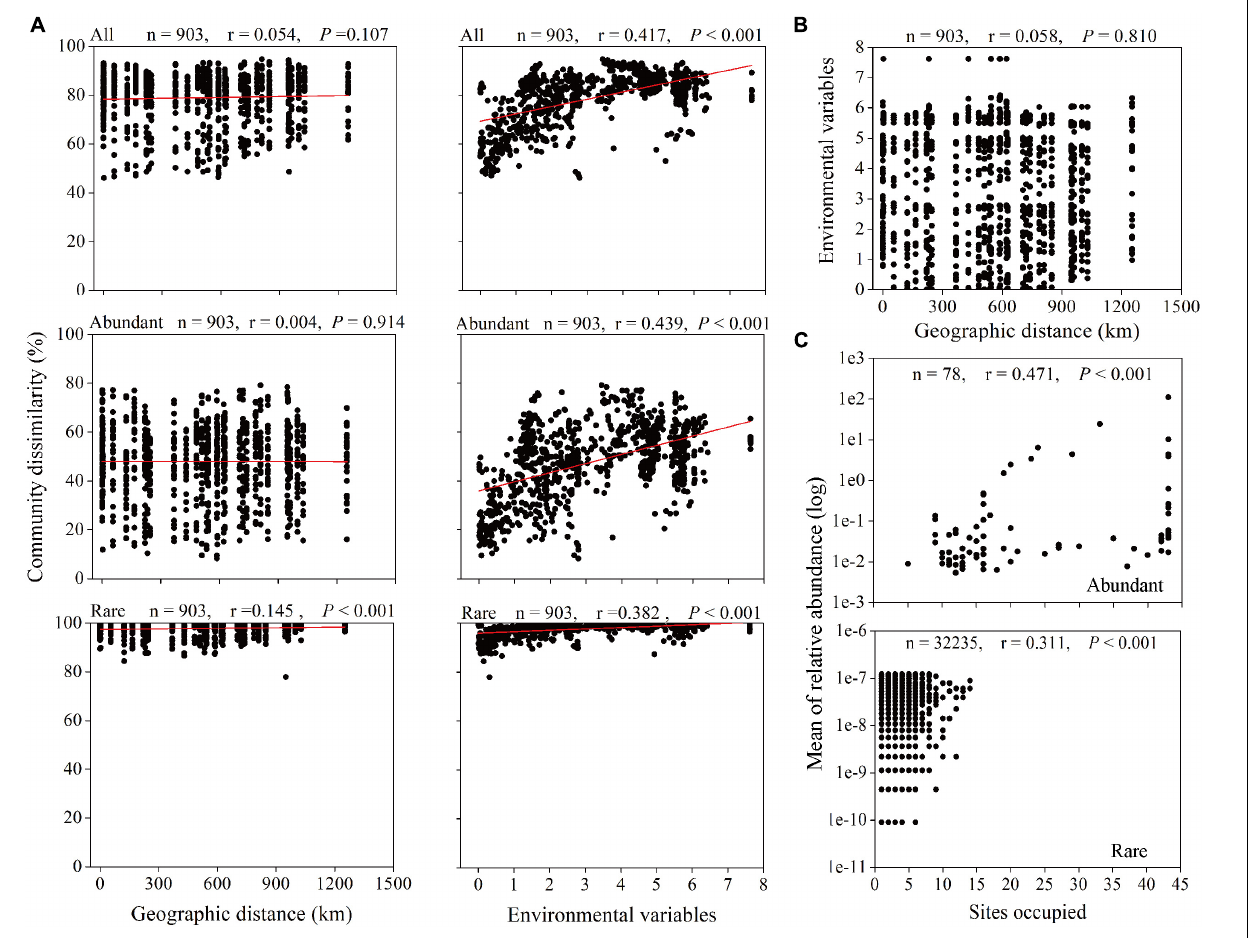
FIGURE 5 | Relationships between microbial community, geographic distance, and environmental factors. (A) Spearman’s rank correlations between the Bray–Curtis dissimilarity of microbial community and geographic distance and the Euclidean distance of environmental variables. The n is the number of comparisons, and all seven environmental variables were used. (B) Spearman’s rank correlation between the Euclidean distance of environmental variables and geographic distance. (C) Abundance-occupancy relationship of microbial taxa. Spearman’s rank correlation between mean relative abundance of abundant and rare taxa and number of sites occupied ( n is the number of